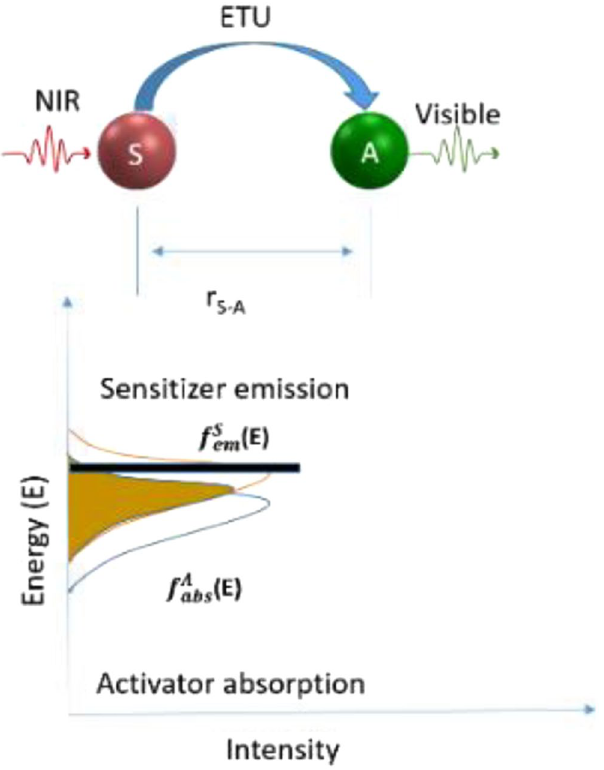
Figure 7. Schematic diagram of energy transfer upconversion ((ETU) in sensitizer to activator, (S-A) coupled